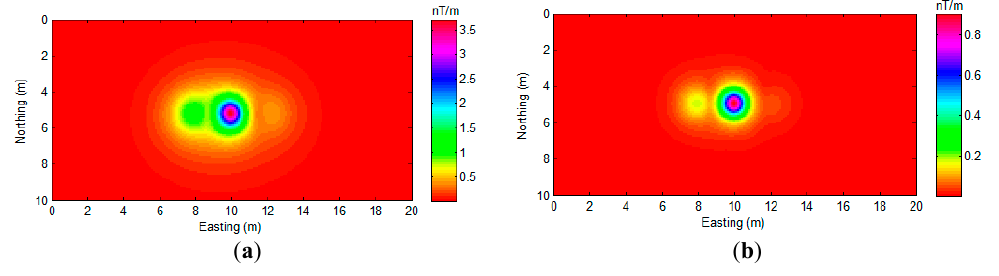
Figure 10. ( a ) AS map of Figure 8 data, and ( b ) NSS map of Figure 8 data.